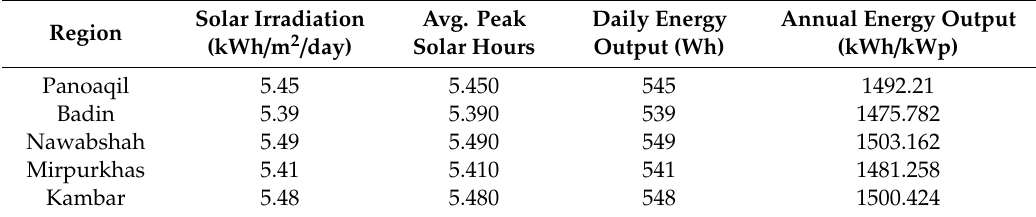
Table 3. Potential of solar photovoltaic (PV) power generation in selected regions of Sindh, Pakistan. Solar Irradiation Region (kWh / m 2 / day)